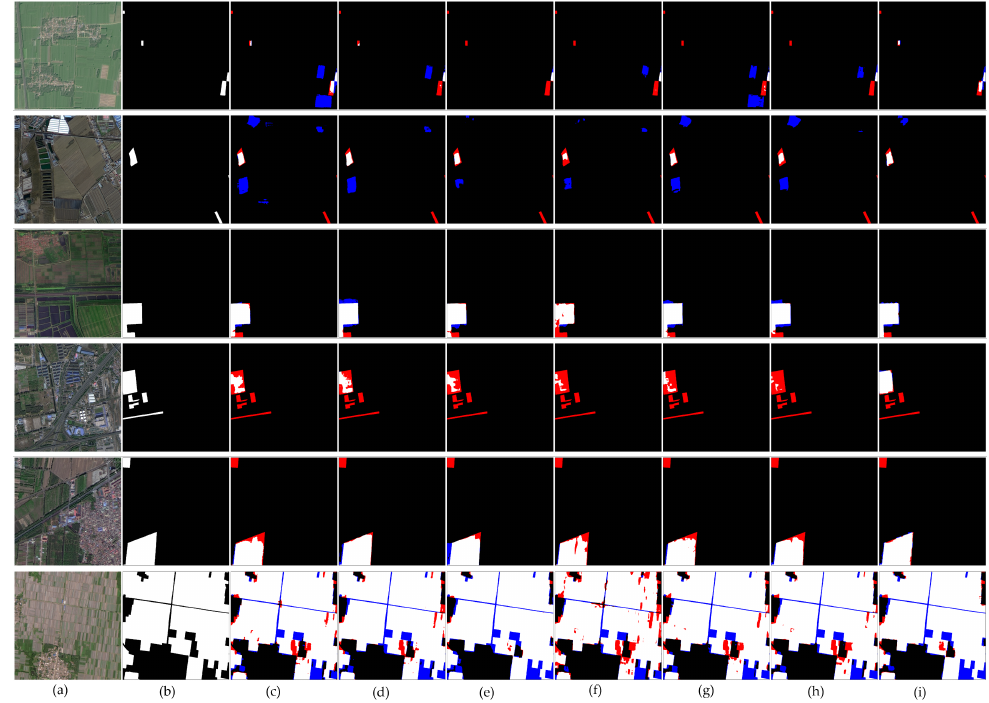
Figure 6. Some examples of the results on the LSAG dataset. Red indicates missed detection (the label value is a greenhouse but is not recognized), and blue indicates false detection (the label value is not a greenhouse but is incorrectly identified as a greenhouse). From left to right: ( a ) Gaofen-1 satellite image; ( b ) Ground truth; ( c ) UNet; ( d ) PAN; ( e ) DeepLabV3+; ( f ) UNet++; ( g ) HRNet; ( h ) AFNet; ( i )